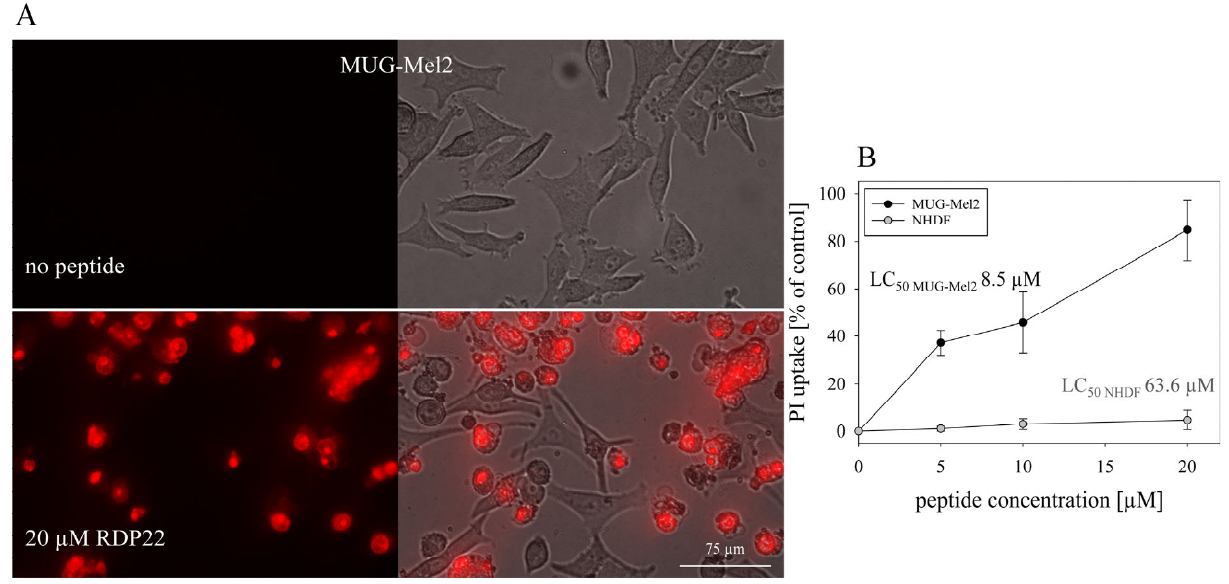
Figure 3. PI uptake: ( A ): Cytotoxic activity of RDP22 on MUG-Mel2 upon 8 h of incubation indicated by microscopic inspection of peptide-induced PI-uptake (red staining), which can be correlated to severe peptide-induced membrane damage and cell death. At 20 µ M peptide concentration the majority of the MUG-Mel2 cells are killed. ( B ): PI-uptake and cell death of MUG-Mel2 (black circles) were also confirmed by fluorescence spectroscopy upon 8 h induced by up to 20 µ M of RDP22. At the respective concentrations of RDP22, NHDF cells (gray circles) [9] are only harmed less than 5%. The data set represents the outcomes of at least three independent experiments.